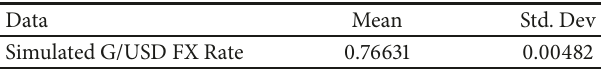
Table 7: Descriptive Statistics of the Simulated GBP/USD FX Rate. Data Mean Std. Dev